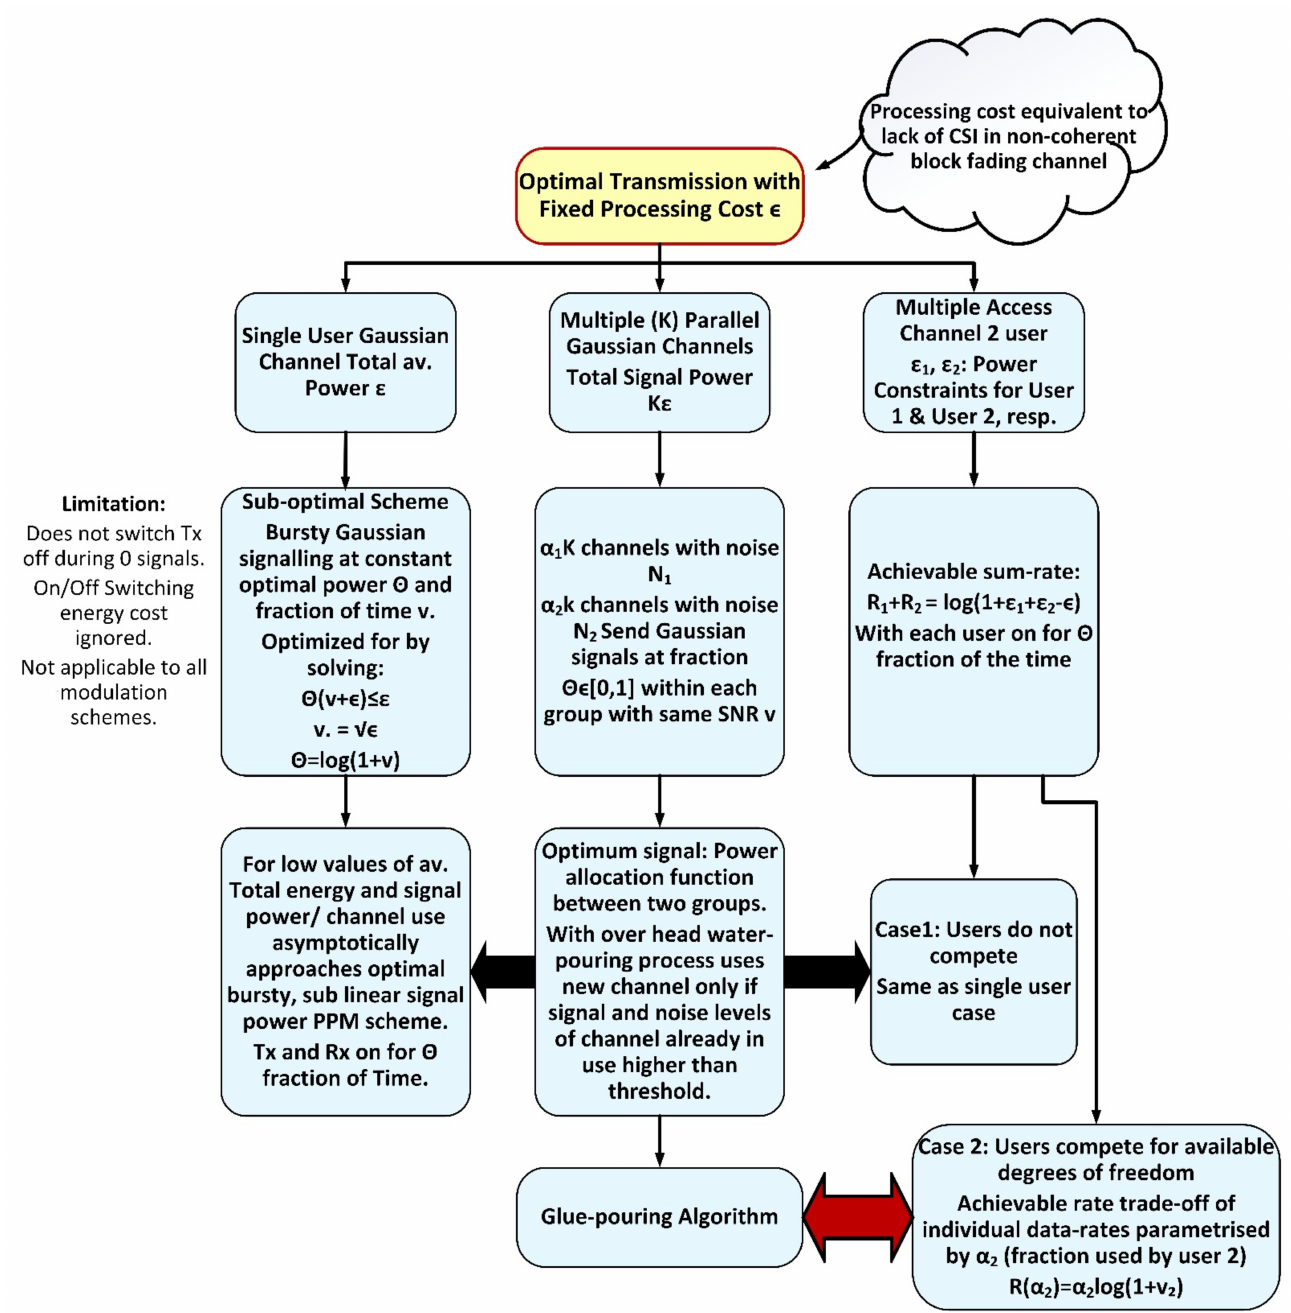
Figure 4. Transmission optimization schemes with processing cost (glue-pouring